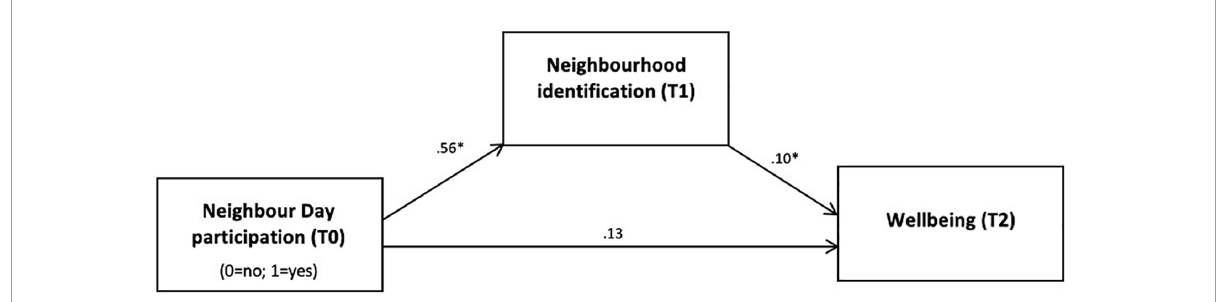
FIGURE3 Neighbour Day participation protects wellbeing following COVID lockdown via neighbourhood identification. N = 440. Indirect effect was significant, 0.05 (0.01, 0.10). Total effect was significant, β = 0.18, p = 0.041. Fully mediated via neighbourhood identification. Standardised beta coefficients are provided for each pathway in the model, ∗ p < 0.05. Covariates included were wellbeing at T1, age, gender, relationship status, employment status, education, and neighbourhood socioeconomic status.